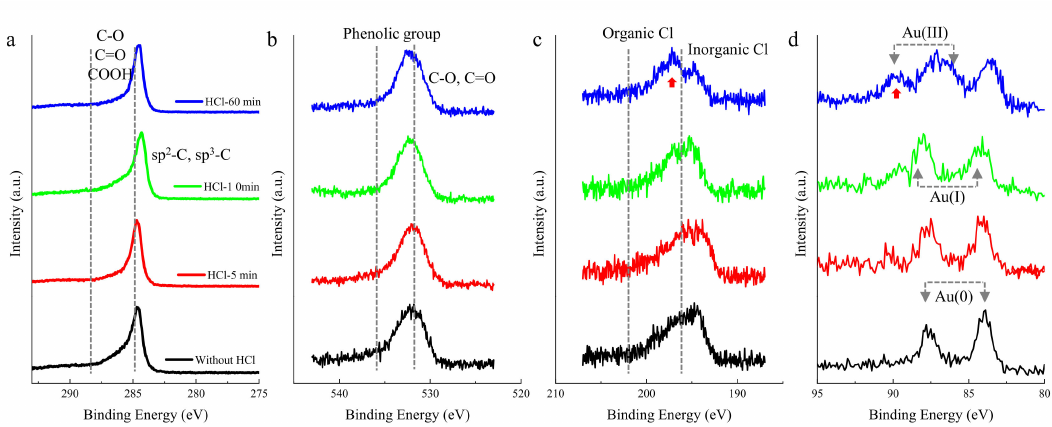
Figure 1. XPS spectrum of ( a ) C 1s, ( b ) O 1s, ( c ) Cl 2p, and ( d ) Au 4f XPS spectra of Au/C catalysts with HCl sequence